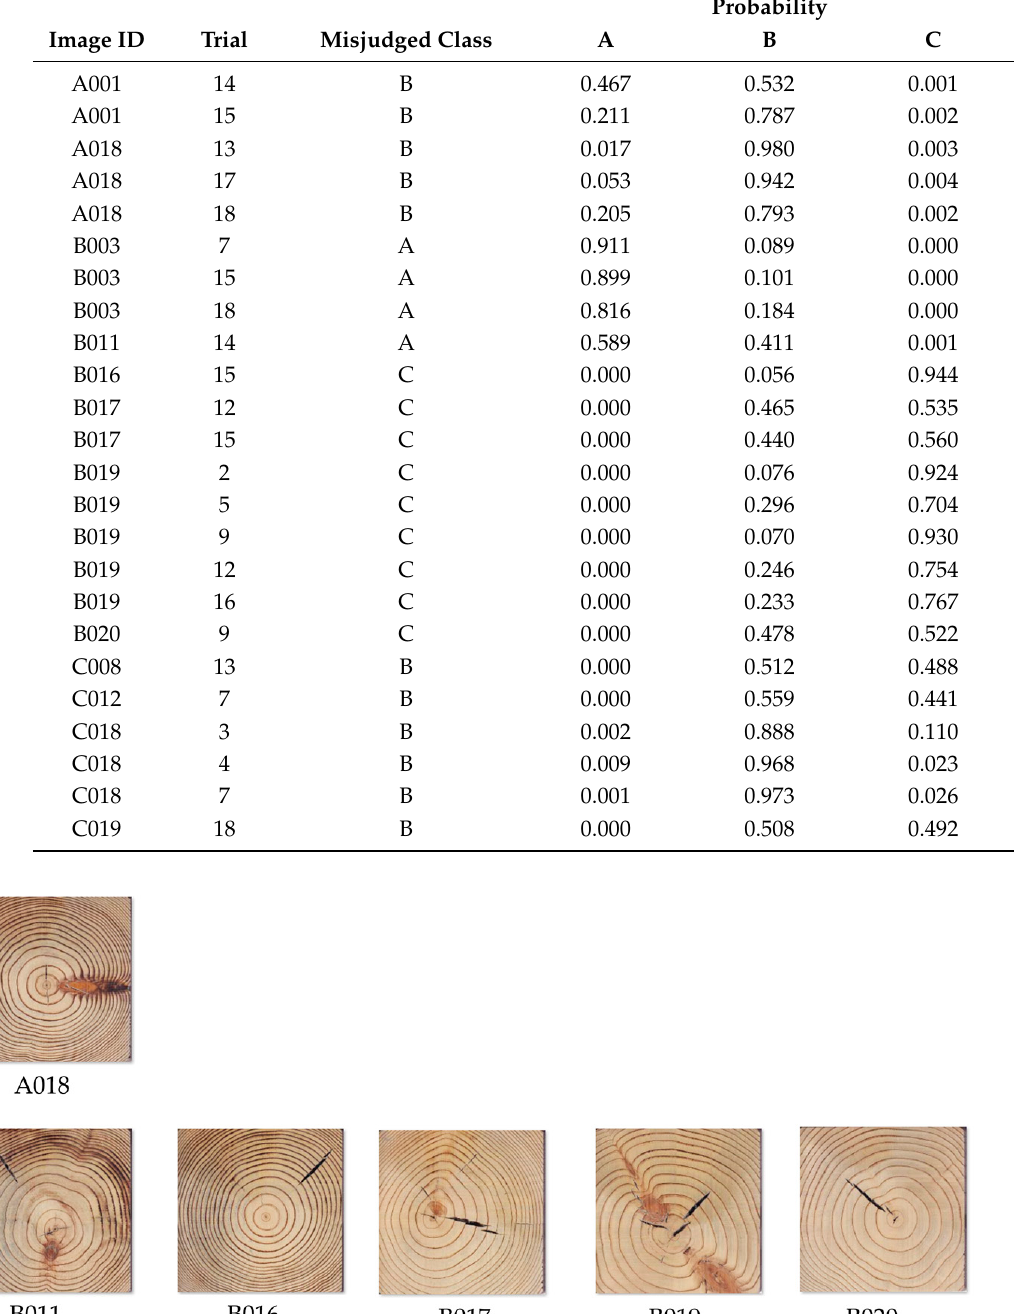
Table 7. Misclassified image IDs, estimated classes, and probabilities of softmax layer.